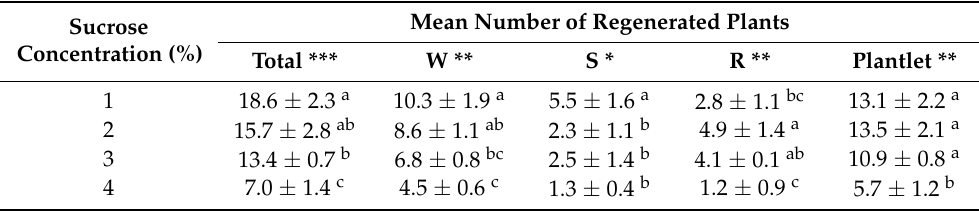
Table 4. Post-effect of sucrose concentration in the germination medium on plant regeneration.